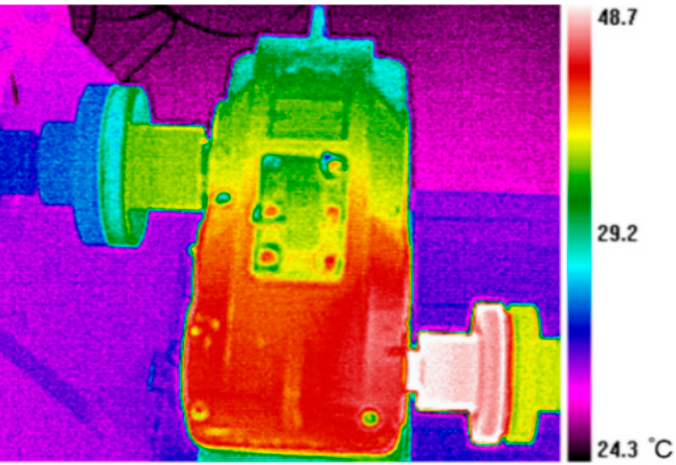
Figure 4. The infrared thermal image of a reducer.